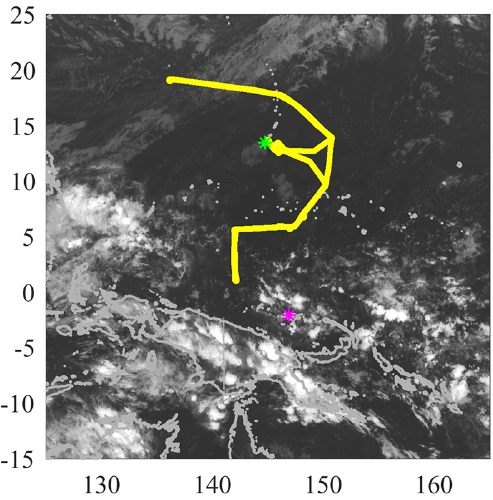
Figure 3. MTSAT infrared satellite image from 12 February at 12:00UTC, coincident with flight RF01 (yellow track). Green as- terisk denotes location of Guam; magenta asterisk denotes that of Manus Island. Convection is centred mostly around the Maritime Continent on this day.